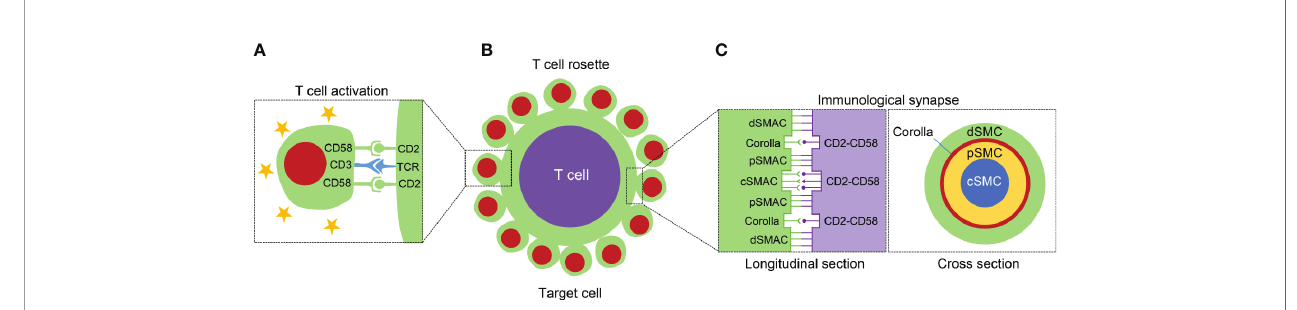
FIGURE 1 | The structure diagram with regard to T cell activation, T cell rosette, and immunological synapse (IS). (A) The left panel displays that the CD2-CD58 interaction facilitates the T cell activation through offering the necessary second signal and assisting TCR-mediated stimulation. (B) The middle panel exhibits the formation of T cell rosette mainly mediated by the binding of CD2 with CD58. (C) The IS can be classi fi ed into different supramolecular activation complexes (SMAC), central, peripheral, and distal SMAC (c, p and dSMAC, respectively). In addition to the cSMAC, the CD2-CD58 interactions exist between pSMAC and dSMAC, and form a ring-like structure, called “ corolla ” . The right panel shows the longitudinal and cross section